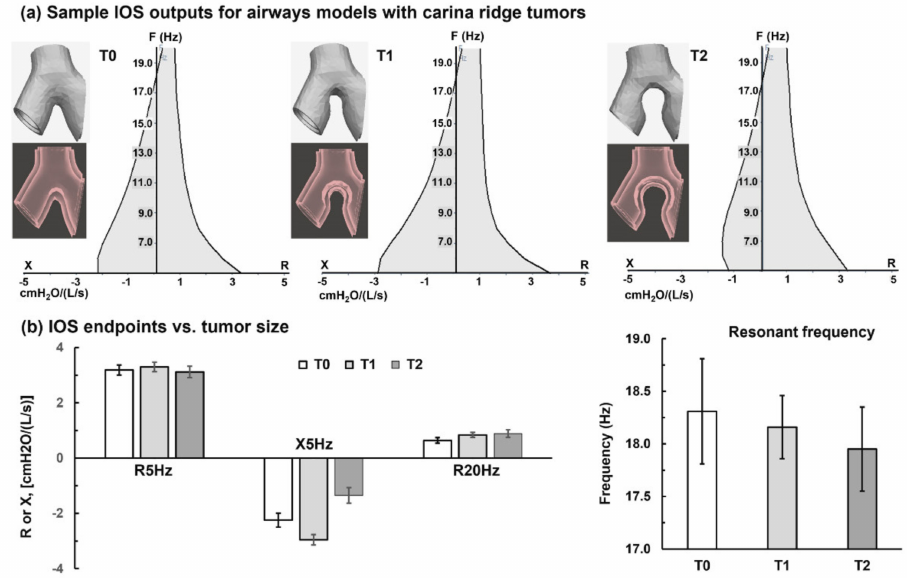
Figure 2. IOS characterization of the mouth–lung (G6) models with varying carina ridge tumors; ( a ) sample IOS outputs for the models T0 (no tumor), T1 (small), and T2 (large), and ( b ) comparison of the ISO endpoints (R5Hz, X5Hz, R20Hz, and resonant frequency) between T0, T1, and T2. The variables in ( a ) are the resistance R (cmH 2 O/(L/s)) in the positive x -axis, reactance X (cmH 2 O/(L/s)) in the negative x -axis, and frequency (Hz) in the y -axis. Table 1. Sample IOS outputs for lung casts retaining different generations of lung branches: G6